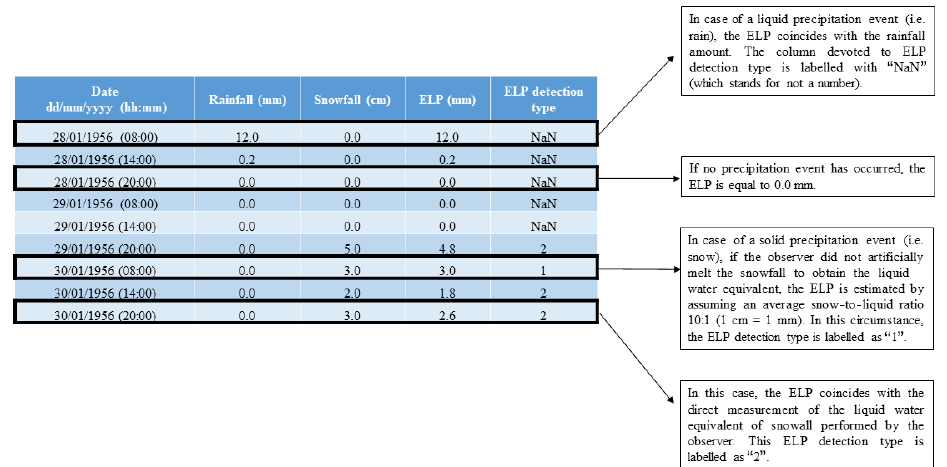
Figure 4. Summary of the strategy used to assess the equivalent liquid precipitation (ELP) parameter. The left table has been obtained by adapting an extract of the digital version of the MVOBS dataset available from the NOAA’s NCEI repository (Capozzi et al., 2019). It lists the sub-daily precipitation data observed between 28 and 30 January 1956. From left to right: rainfall (mm), snowfall (cm), ELP (mm) and ELP detection type (expressed as a numeric or textual label). The rows highlighted in black present different ELP estimation